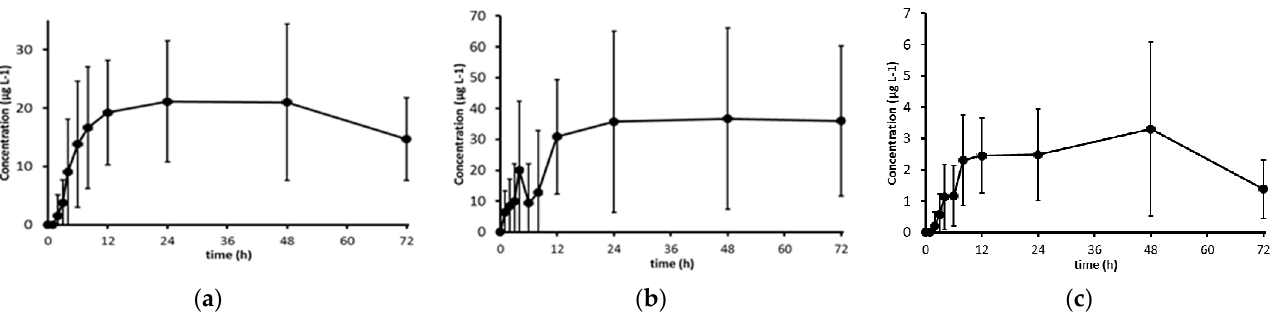
Figure 2. Average profile of plasma concentrations of lutein ( a ), β -carotene ( b ) and zeaxanthin ( c ) of the 11 volunteers. Error bars represent SEM. Shown values represent C min -subtracted